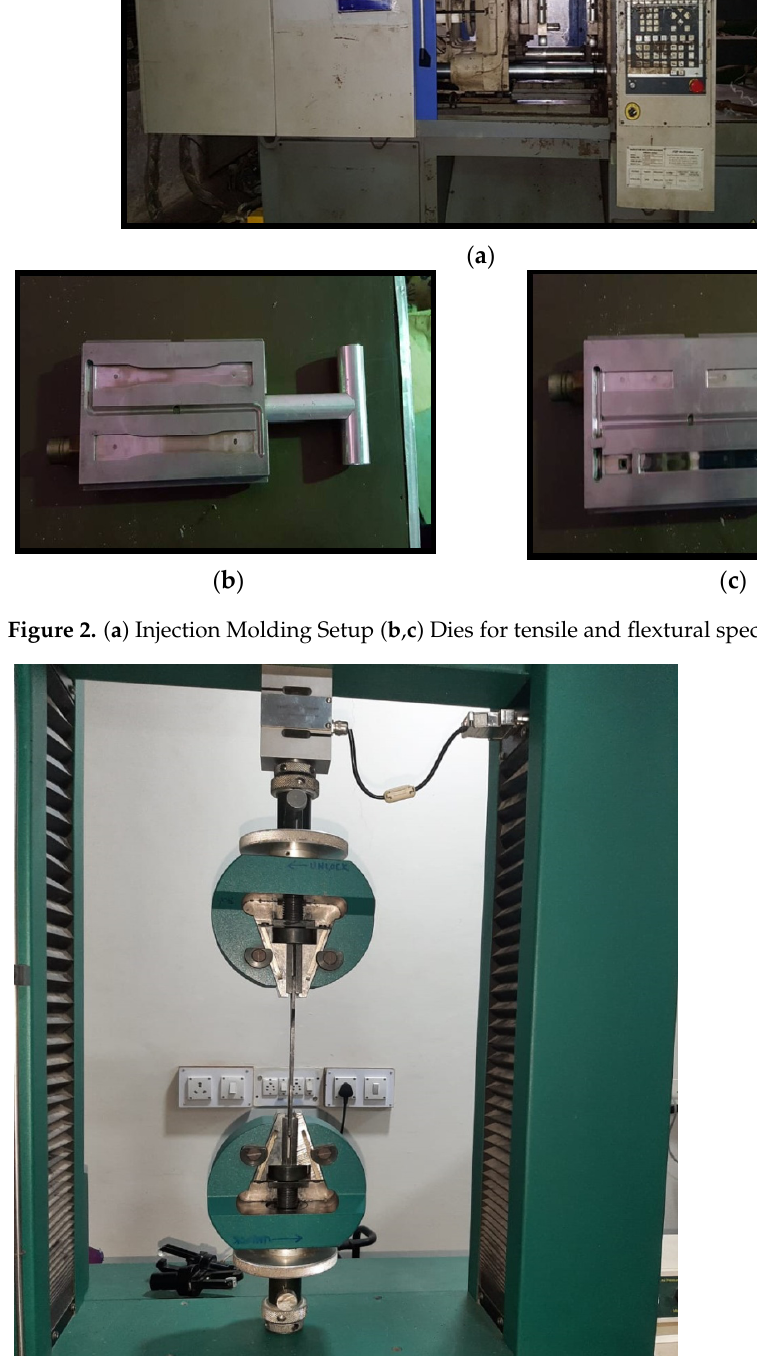
Figure 2. ( a ) Injection Molding Setup ( b , c ) Dies for tensile and flextural specimen.